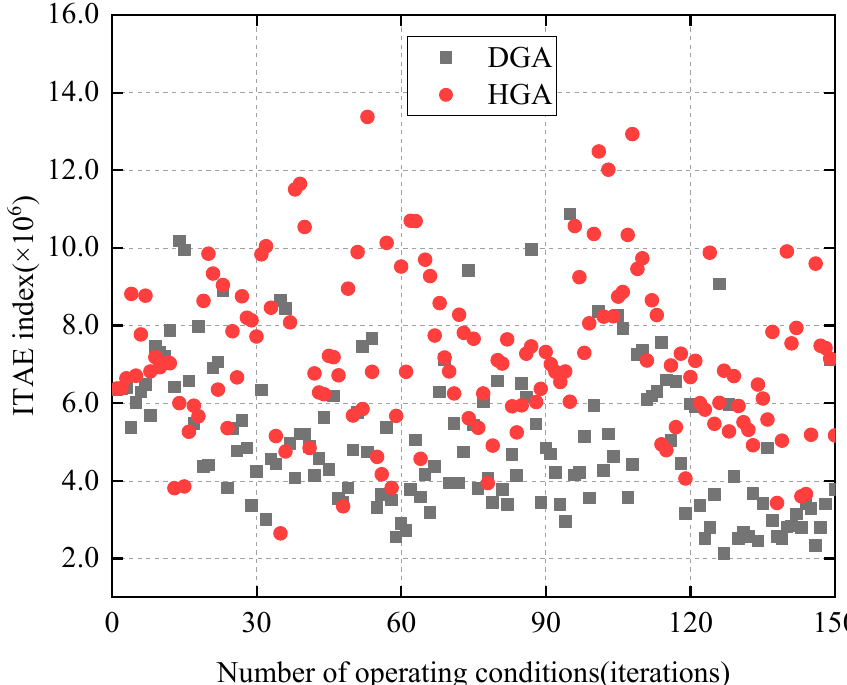
Figure 11. Scatter diagram of ITAE index of two genetic algorithm control strategies 150 times NEDC. Table 6. Statistical table of ITAE index in 150 NEDC working conditions.